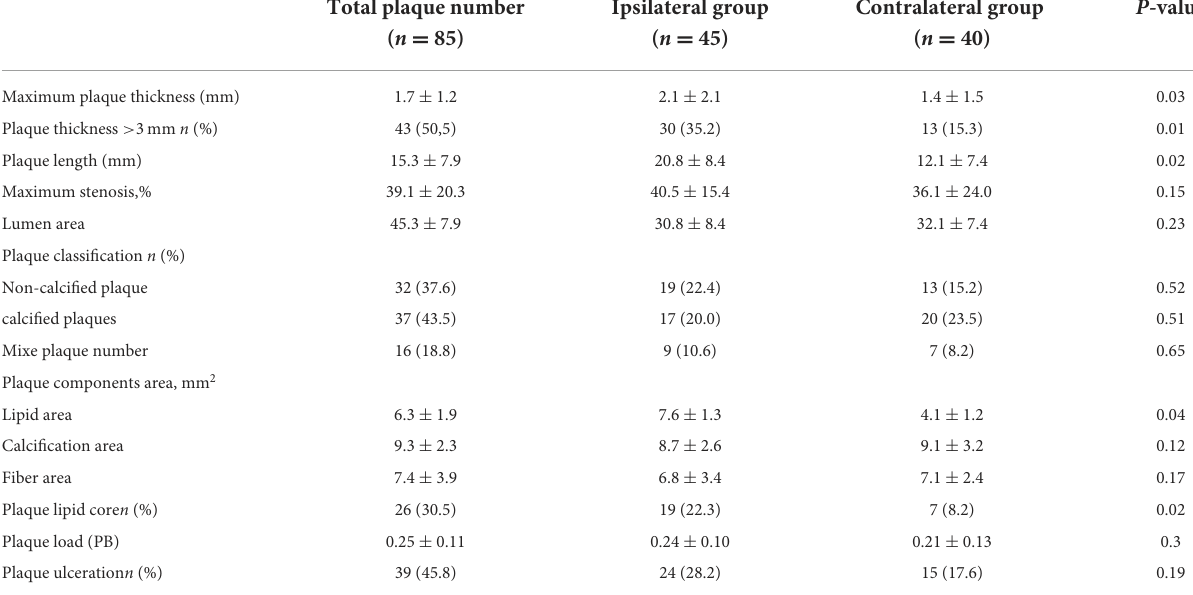
TABLE 2 Imaging features of non-stenotic plaques ipsilateral vs. contralateral to the side of the stroke [ x ± s or n